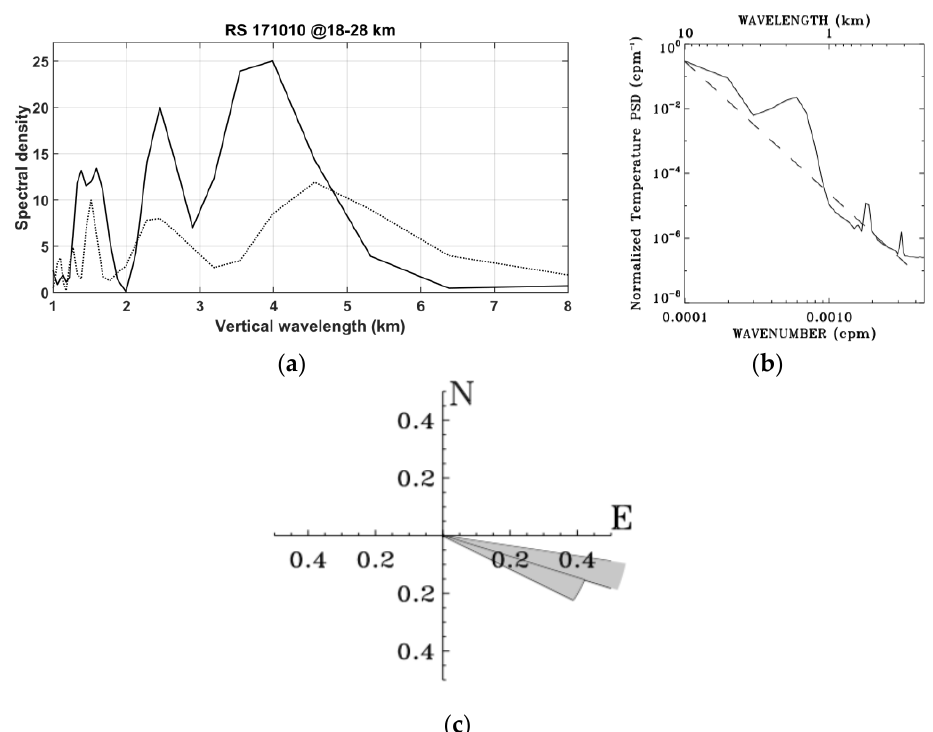
100 m, respectively.